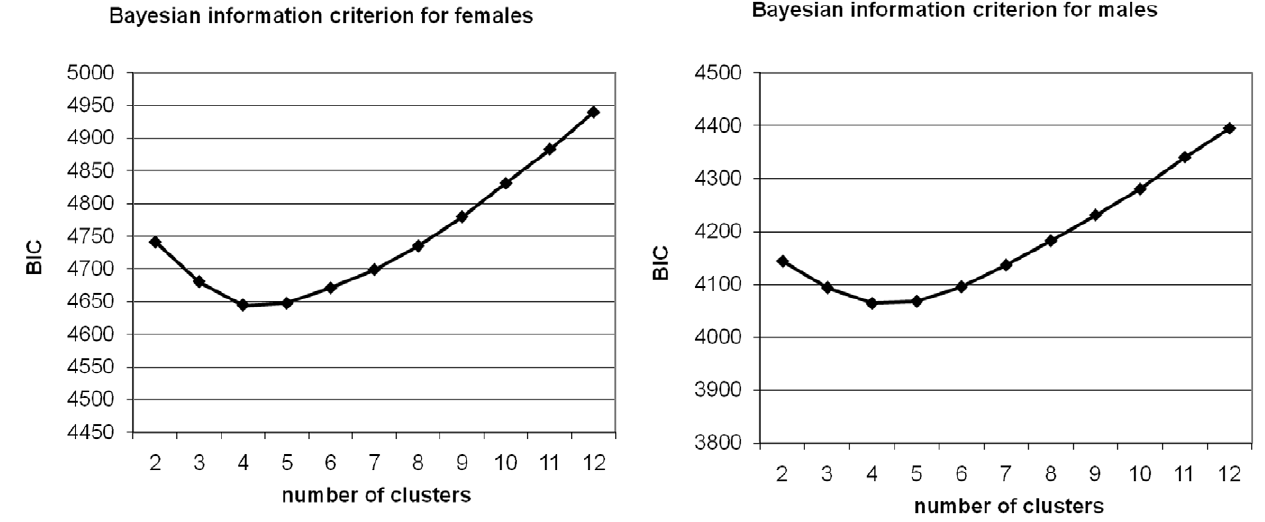
Figure 1. Bayesian information criterion (BIC) scores for various cluster sizes. Clustering of the subscales showed stable results with an optimum of four clusters in both females (left) and males (right).